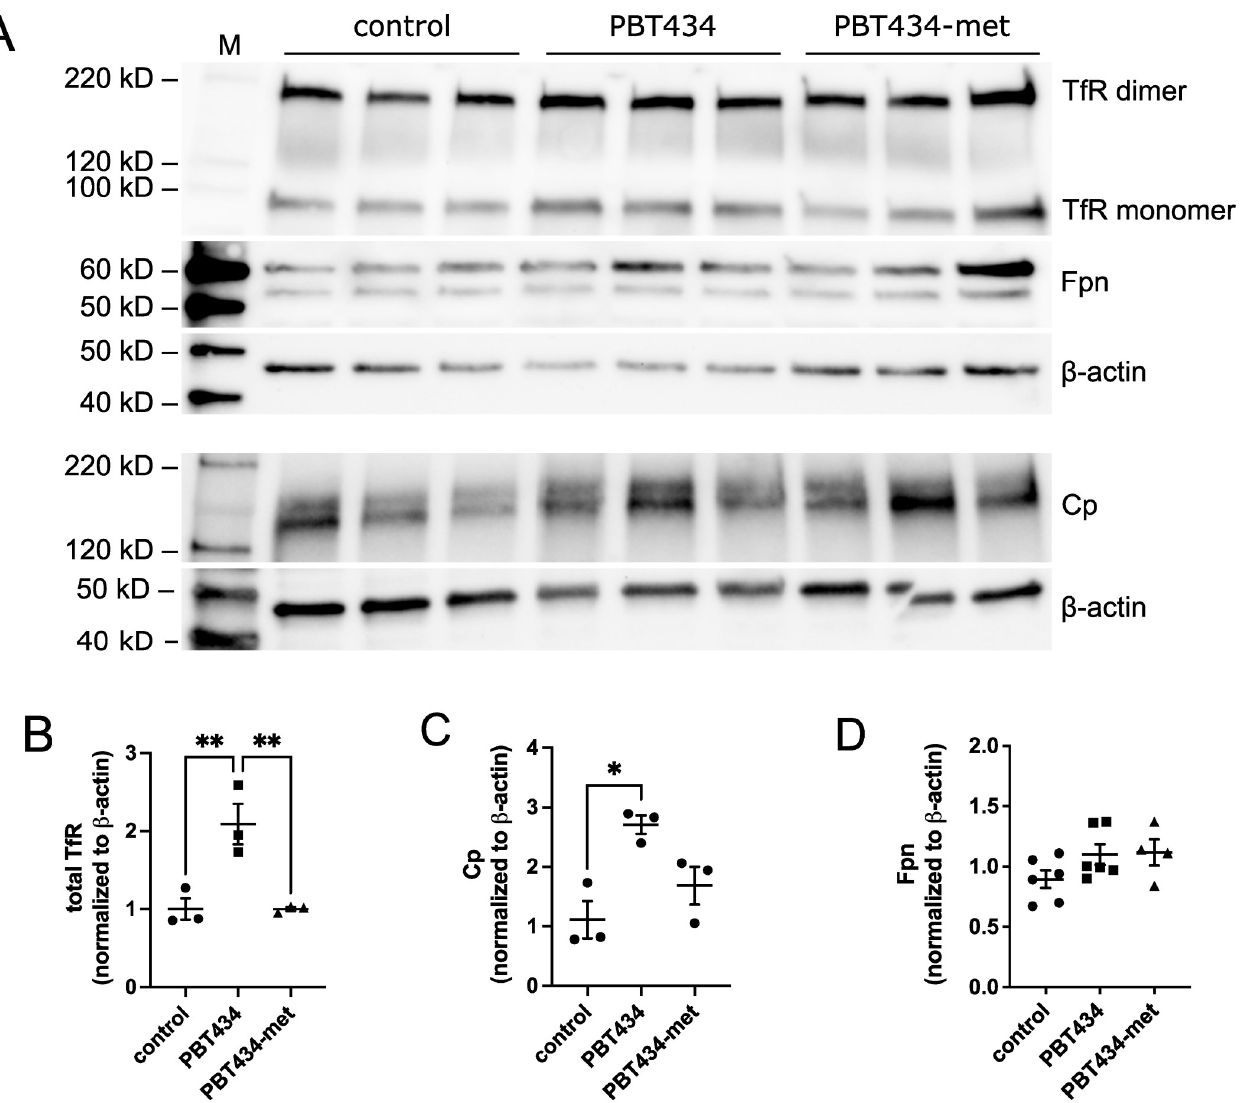
Fig 7. Western blot analysis of iron metabolic protein abundance in PBT434-treated hBMVEC. hBMVEC were treated with 20 μ M PBT434 or PBT434-met for 24h and then cells were processed for Western blotting ( A ). Blots were probed for either anti-Fpn, anti-TfR, or anti-Cp, and anti- β -actin as a loading control. Band intensities were normalized to β -actin, and quantification of the relative band densities are given in panels ( B - D ). Data are represented as mean ± SEM, n = 3–6 biological replicates. Statistical significance was tested using one-way ANOVA and Tukey’s multiple comparison test; � , p < 0.05, �� , p < 0.01 compared to indicated